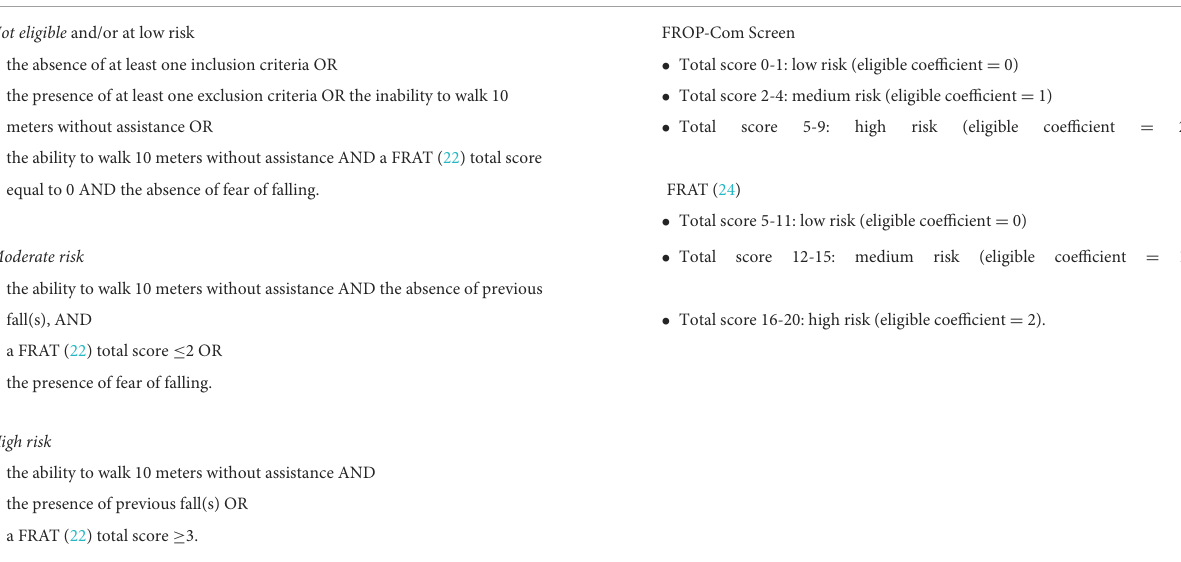
TABLE 1 AAE and OAE enrolment algorithms. Anamnestic Assessment of Eligibility (AAE) algorithm Objective Assessment of Eligibility (OAE)